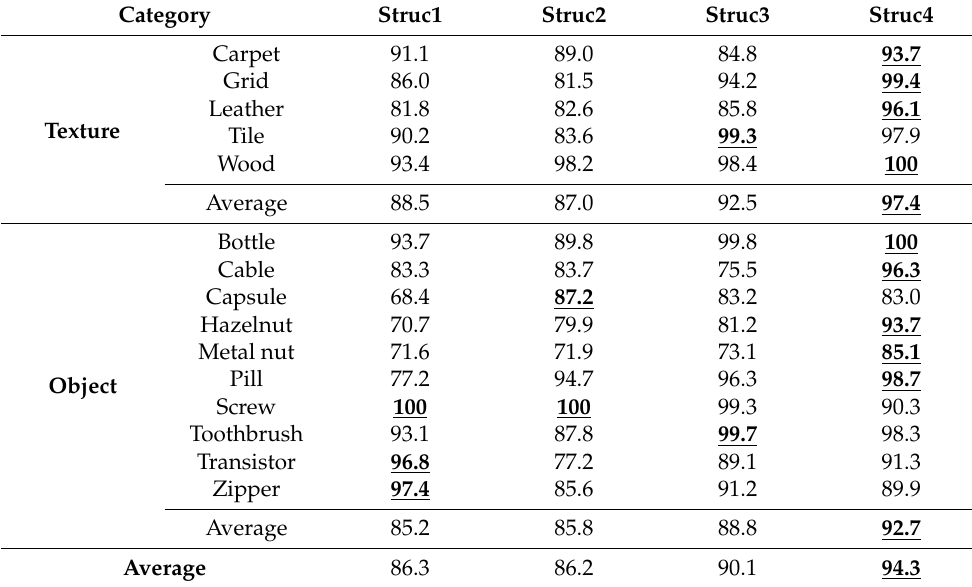
Table 4. The AUC values of different sub-modules on the MVTec dataset. The results in bold and underlined are the best AUC